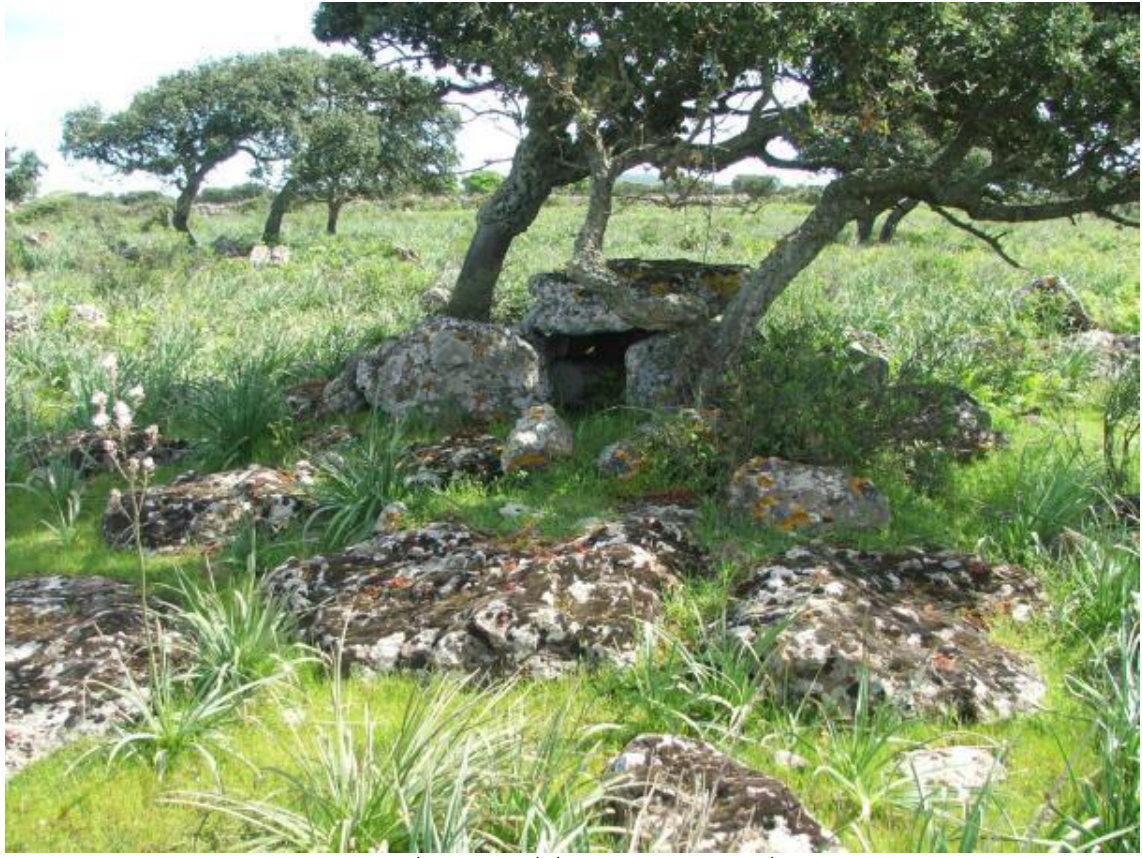
Figure 4. Dolmen Matta Larentu I, Suni (simple type) (photo by R.